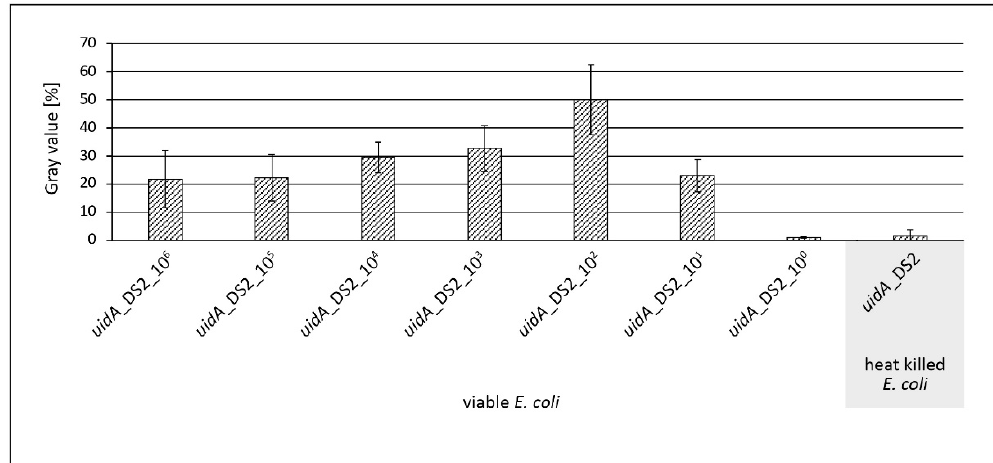
Figure 7. Grey value analysis of PP microarrays to verify the LOD of the newly designed assay. 1 × 10 6 –1 × 10 0 viable and 1 × 10 6 heat killed E. coli cells were amplified by direct, nested v-PCR. PCR products from the second round ( uidA short fragment; 96 bp) were heat denaturized to generate ssPCR products. For specific biomolecule interaction in the PP spoon cavity, DNA hybridization and enzyme binding were combined. Enzymatic silver deposition on the microarrays was performed to generate robust endpoint signals.